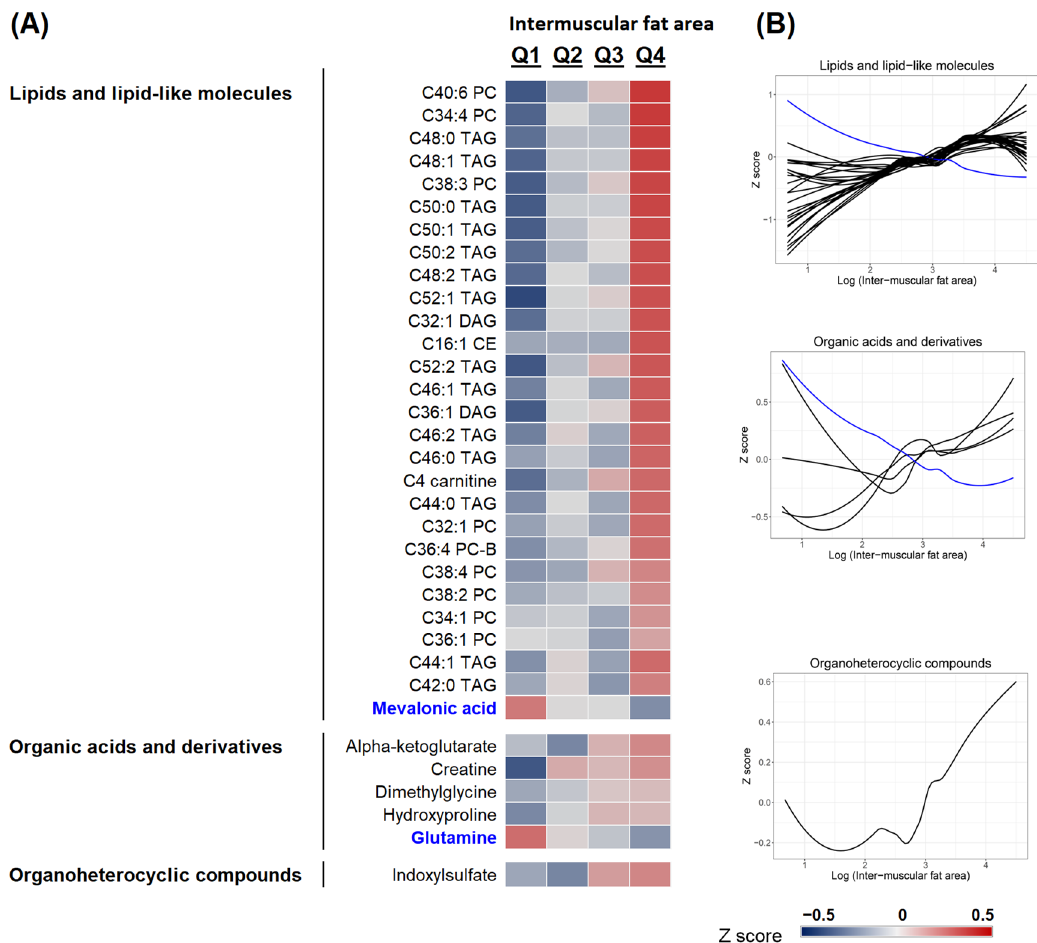
Figure 1. Superclass of 34 metabolites associated with intermuscular fat area. ( A ) Plasma levels of metabolites as standardized Z-scores across quartiles (Q) of intermuscular fat area. ( B ) Metabolites that were positively (in black) and negatively (in blue) correlated with intermuscular fat area after adjusting for age, weight, physical activity, total number of medications, and smoking with a false discovery rate of ≤ 0.25 to account for multiple comparisons.